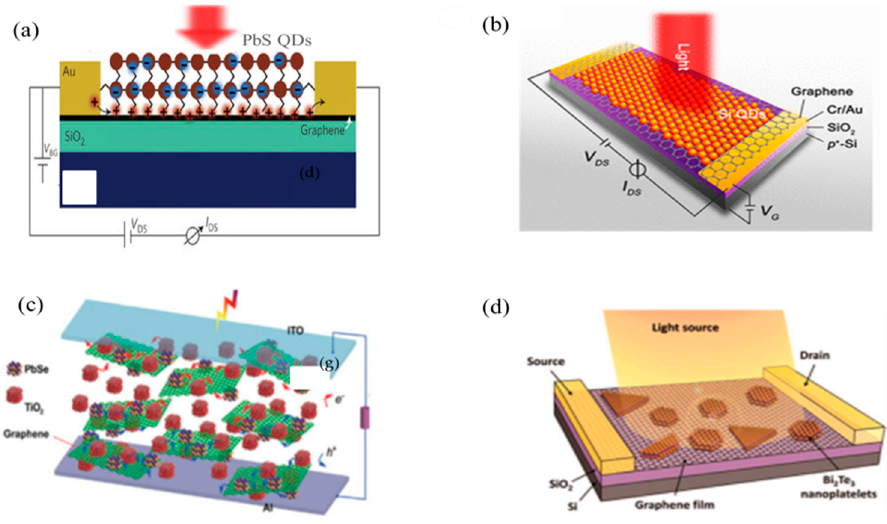
Figure 9. Schematics of different hybrid phototransistors based on heterostructure combinations. ( a ) PbS CQDs/graphene structure (reproduced with the permission of Reference [10]. Copyright 2012, Nature Publishing Group); ( b ) B-doped Si QD/graphene, shows the intense near-field absorption